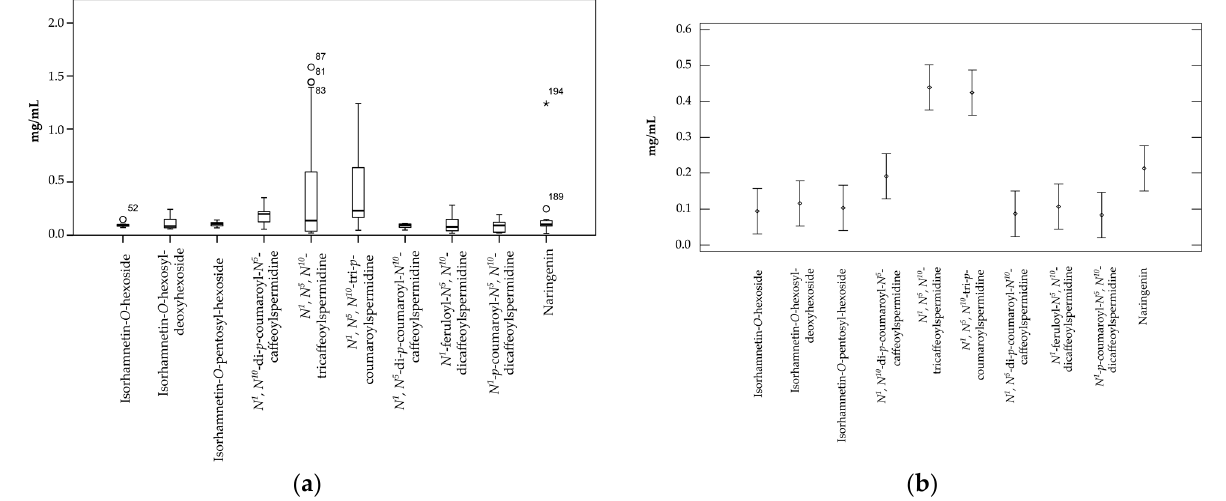
Figure 3. Graphical representation of the quantitative values of each compound: ( a ) representation of the range values of each compound by means of a boxplot; ( b ) mean and 95% intervals based on Fisher’s least significant difference (LSD) for each compound. The asterisk (*) indicates extreme outliers in the data.